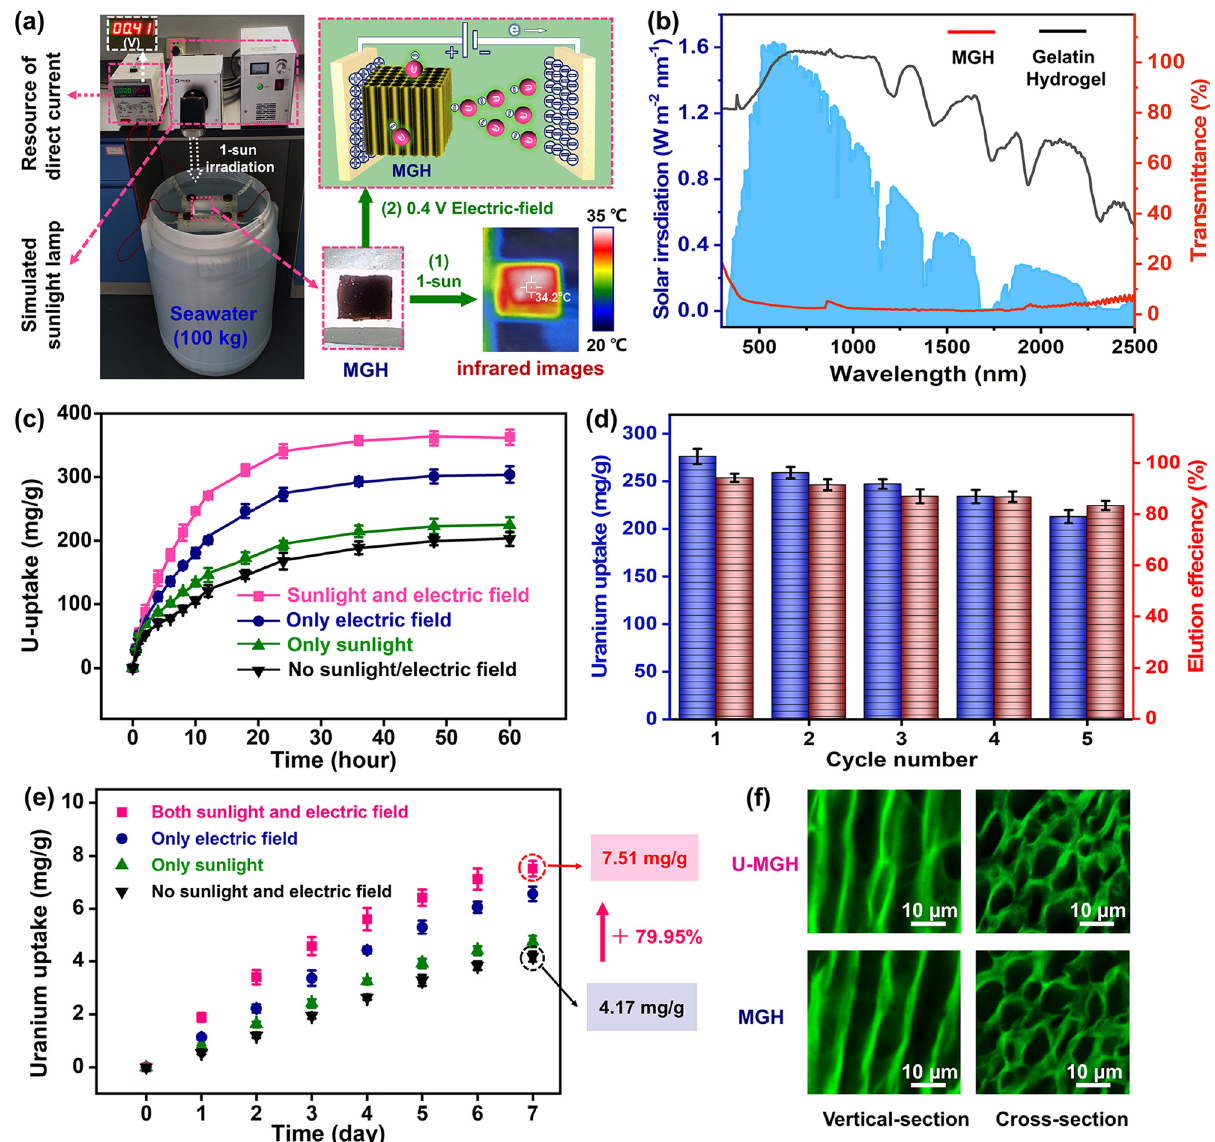
Figure 4: ( a ) System and schematic diagram of U - adsorbing device enhanced by simulated sunlight and power resource of direct current. ( b ) Comparison of the light transmittance between the MGH and blank gelatin hydrogel over 200 – 2,500 nm wavelength range. ( c and e ) Comparison of the MGH U - adsorbing capacity from natural sea water under four di ff erent external conditions within 8 ppm U - spiked simulated seawater and seawater, respectively. ( d ) U - adsorbing performance ( in 8 ppm U - added simulated sea water ) and U - removal e ffi ciencies during 1 – 5 adsorbing - desorbing cycles. ( f ) LSCM images of the original MGH and U - MGH after bi - enhanced U - extraction from seawater for 7